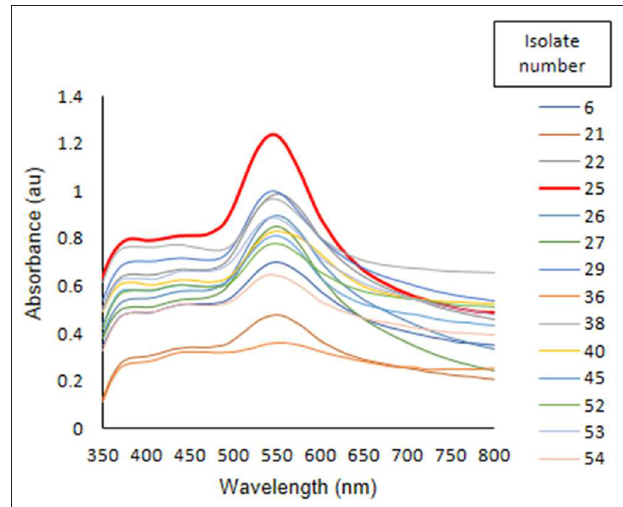
FIGURE 1 | Screening of 14 isolates of Acinetobacter spp. for synthesis of AuNPs.